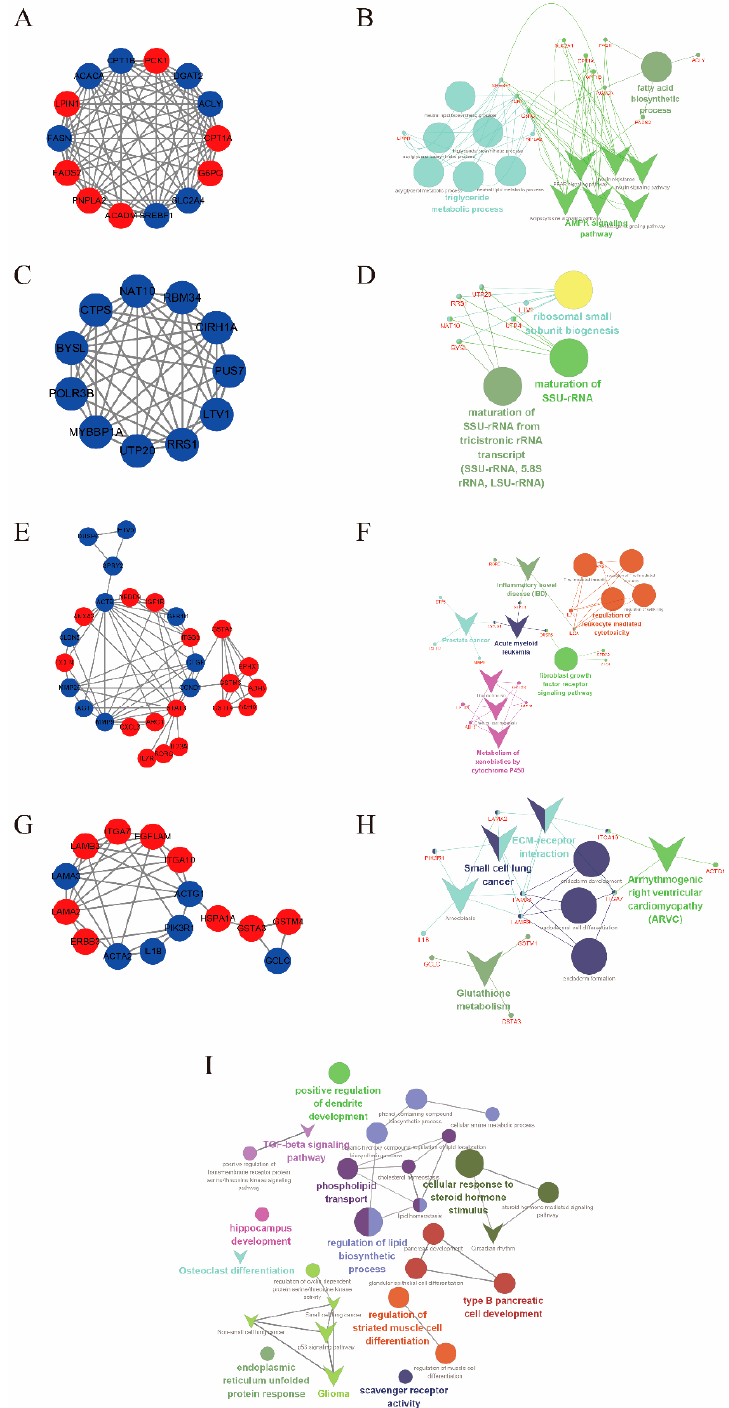
Figure 2. Enrichment analysis of differentially expressed genes (DEGs). ( A , B ) The gene interactive network and the enrichment result of Top 1 Module between RBW and MBW. ( C , D ) The gene interactive network and the enrichment result of Top 2 Module between RBW and MBW. ( E , F ) The gene interactive network and the enrichment result of Top 3 Module between RBW and MBW. ( G , H ) The gene interactive network and the enrichment result of Top 4 Module between RBW and MBW. ( I ) The enrichment result of all DEGs between RAW and MAW. Red represents the upregulated genes and blue represents the downregulated genes in the gene interactive network. Different colors represent different enrichment groups (based on the Cohen’s kappa score) in enrichment analysis. The triangle and circle graph represent the KEGG and GO results, respectively, in the enrichment analysis. MBW (liver samples from the milk group before weaning); RBW (liver samples from the milk replacer group before weaning). MAW (liver samples from the milk group after weaning); RAW (liver samples from the milk replacer group after weaning).